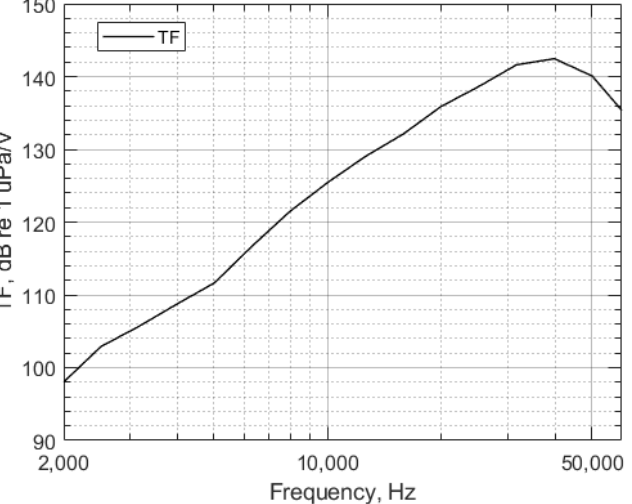
Figure 8. Measured transfer function between the source and sensor in the tunnel.